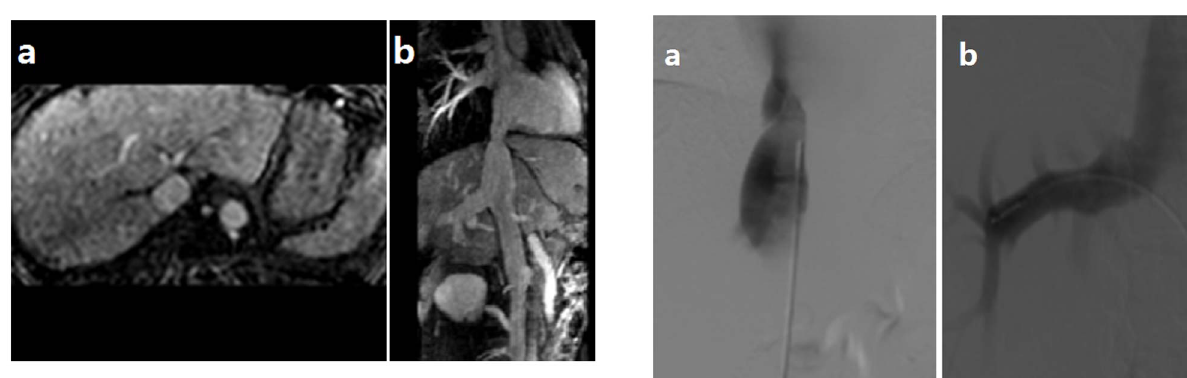
Figure 3. The inferior venocavography through the femoral access. The IVC is obstructed at the secondary porta of liver, and the adopted contrast agent is thin and beam-like (Figure 3 a), the right and rear HVs are remarkably dilated (Figure 3 b).